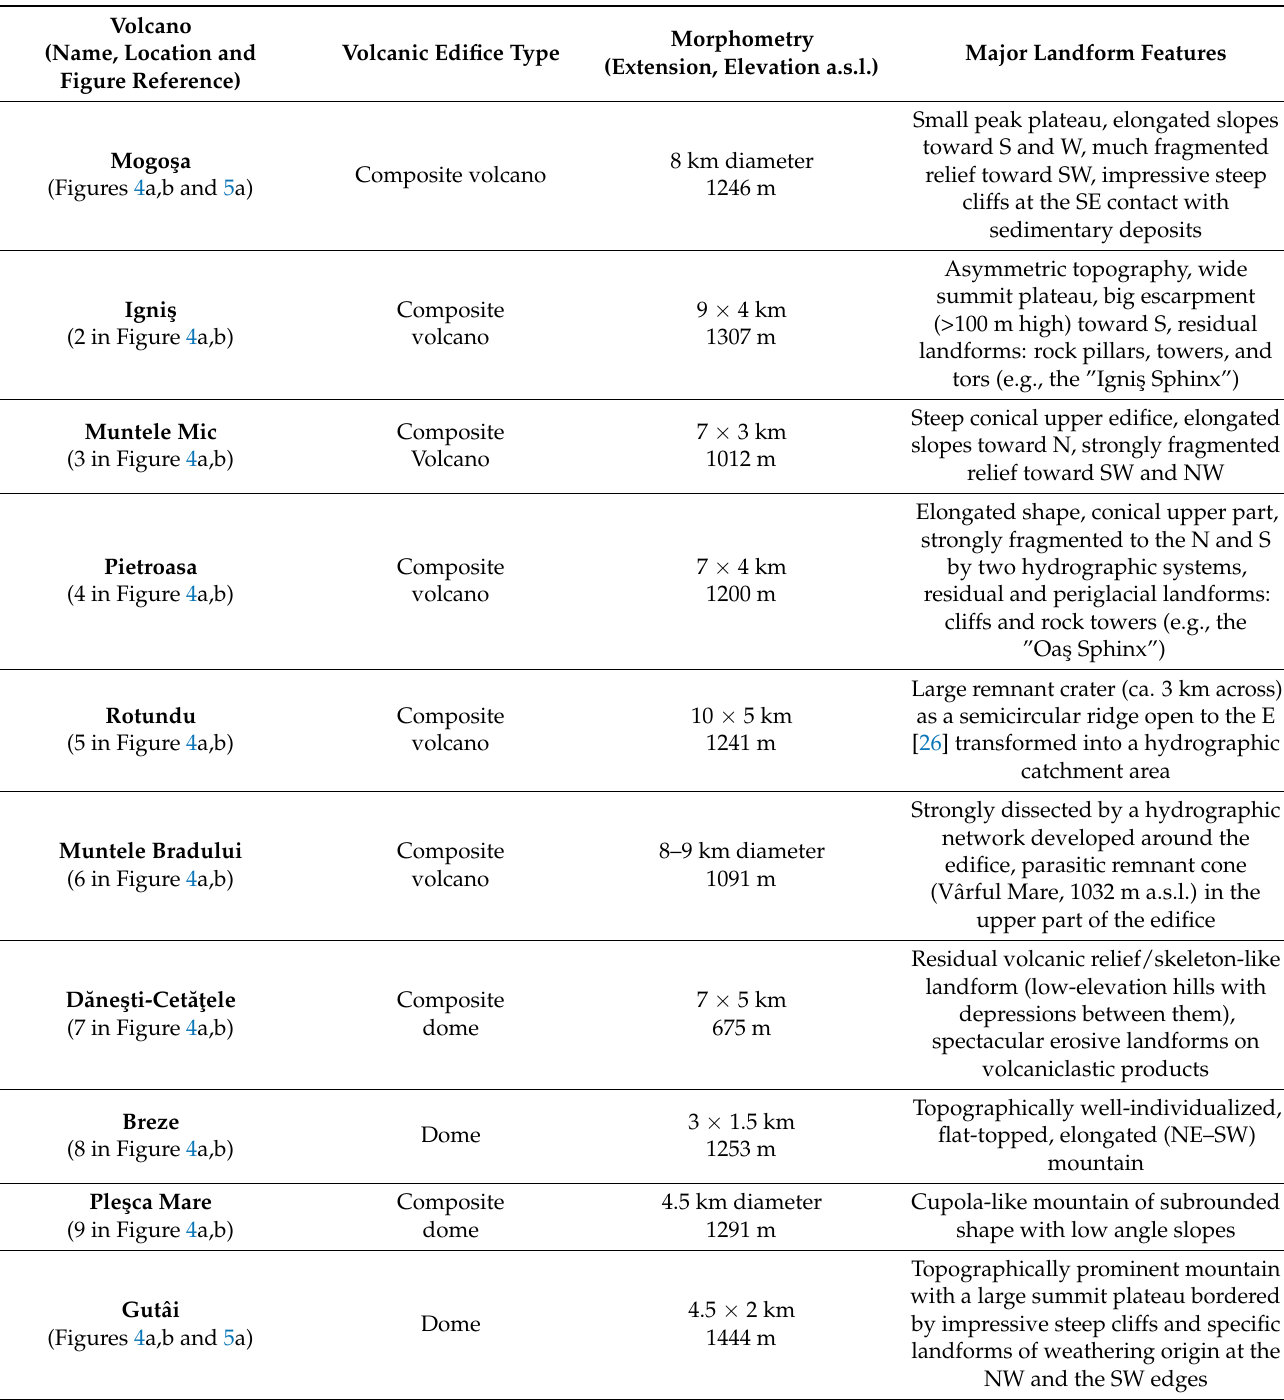
Table 1. Major volcanic and landform features in the Gut â i